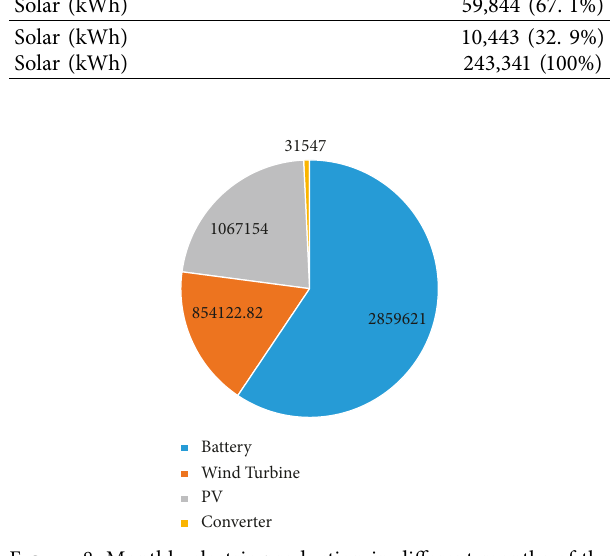
Figure 8: Monthly electric production in different months of the year (Scenario